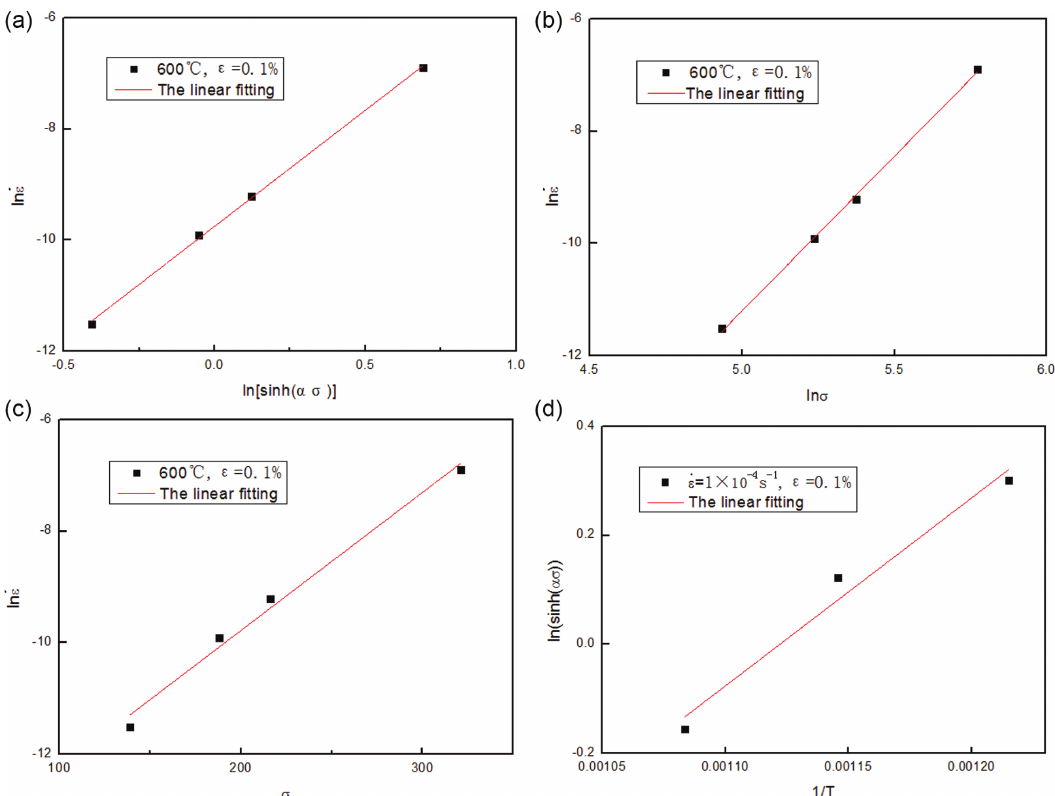
Figure 8: Plots used for calculation of (a) n , (b) and (c) α , (d) Q values.